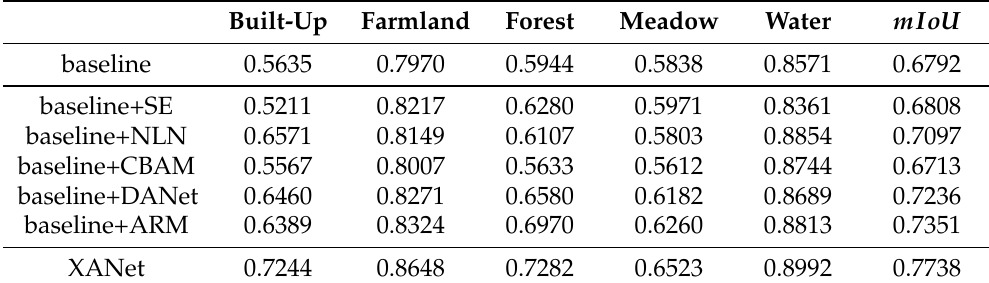
Figure 13. Comparison of segmentation results on the LSC dataset: ( a ) Image; ( b ) Ground truth; ( c ) Baseline; ( d ) Baseline+ SE; ( e ) Baseline+ NLN; ( f ) Baseline+CBAM; ( g ) Baseline+DANet; ( h ) Base- line+ARM; and ( i ) XANet. Table 6. Accuracy comparison of different attention modules on the LSC